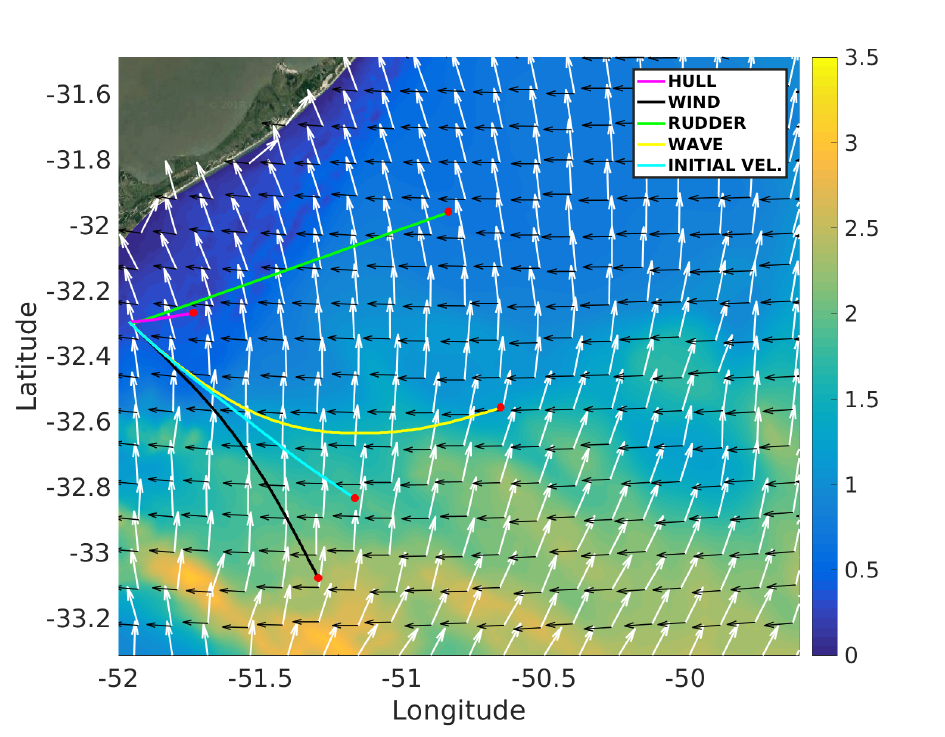
Figure 3. Routes performed by the ship in 5 hours of